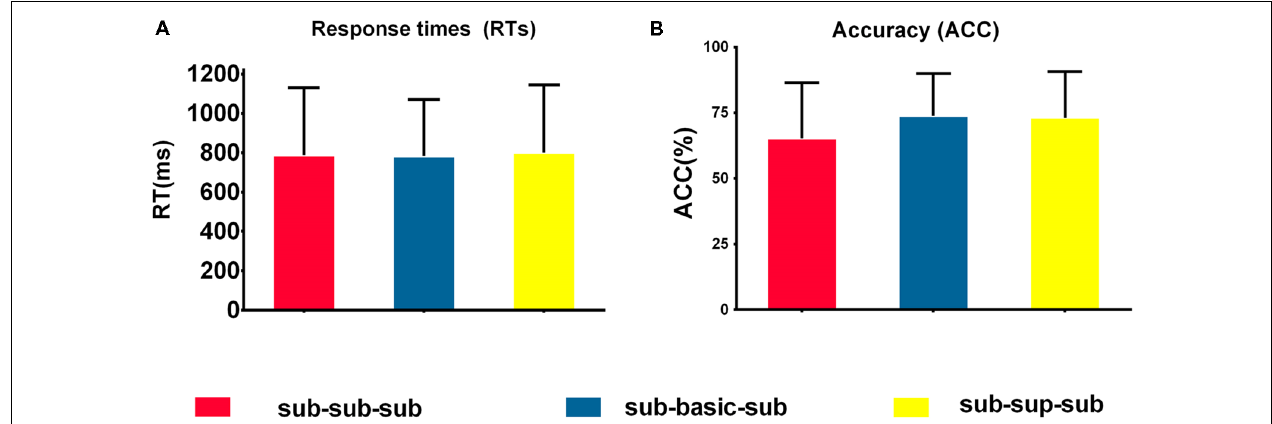
FIGURE 2 | Behavioral performance. (A) Mean response times (RTs) to target stimuli in the three conditions. There were no significant differences among the sub-sub-sub, sub-basic-sub, sub-sup-sub. p > 0.05 [one-way repeated-measures analysis of variance (ANOVA)]. (B) Accuracies in response to target stimuli in the four conditions. There were no significant differences among the sub-sub-sub, sub-basic-sub, sub-sup-sub. p > 0.05 [one-way repeated-measures analysis of variance (ANOVA)], N = 18. For each condition, error bars represent ± SEM across participants. NB. “RT” is response time; “sub-sub-sub,” “sub-bas-sub,” and “sub-sup-sub” represent subordinate-subordinate-subordinate, subordinate-basic-subordinate, and subordinate-superordinate-subordinate, respectively.